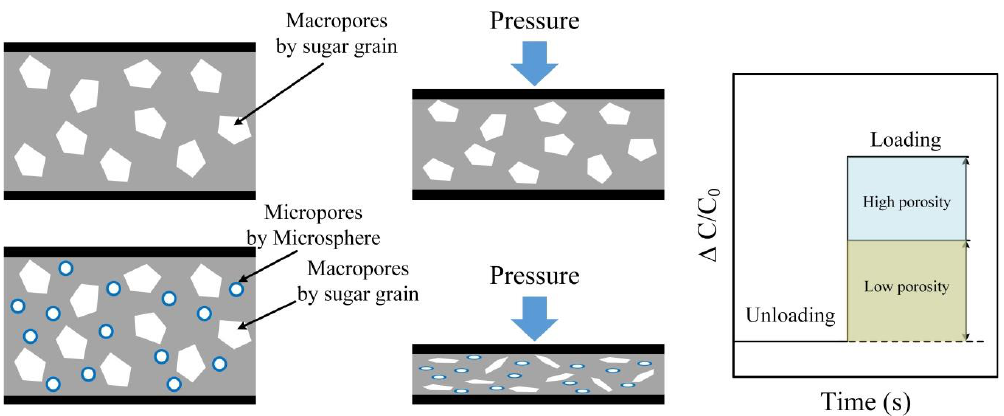
Figure 2. Comparison of the porous PDMS structure and PDMS/MS composite when it compresses with pressure. Bare PDMS structure with low porosity has high elastic resistance, and low sensitivity. However, in cases of the PDMS/MS composite, which has macro and micro pores in the structure, it has low elastic resistance and high sensitivity.